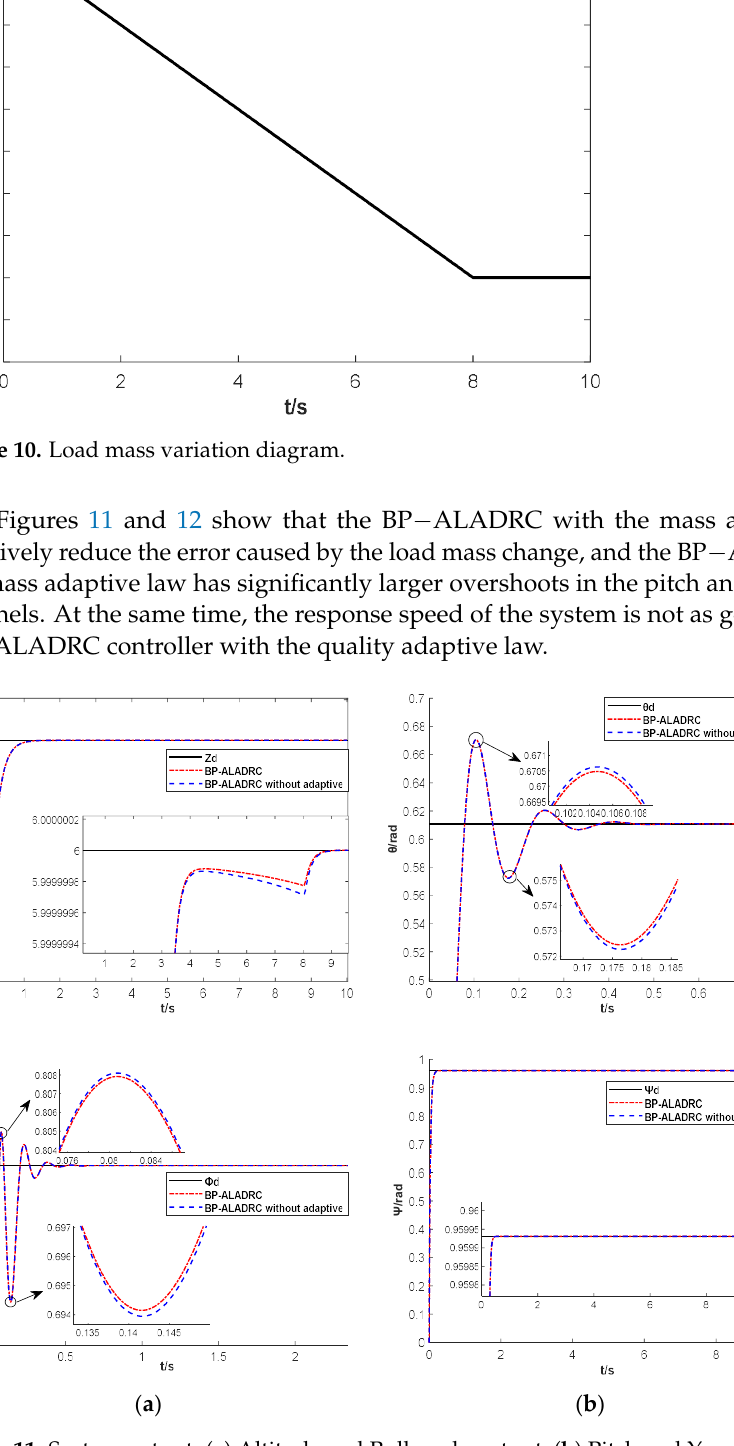
( b ) Figure 12. System output errors: (a) Altitude and Roll angle output errors; (b) Pitch and Yaw angle output errors.